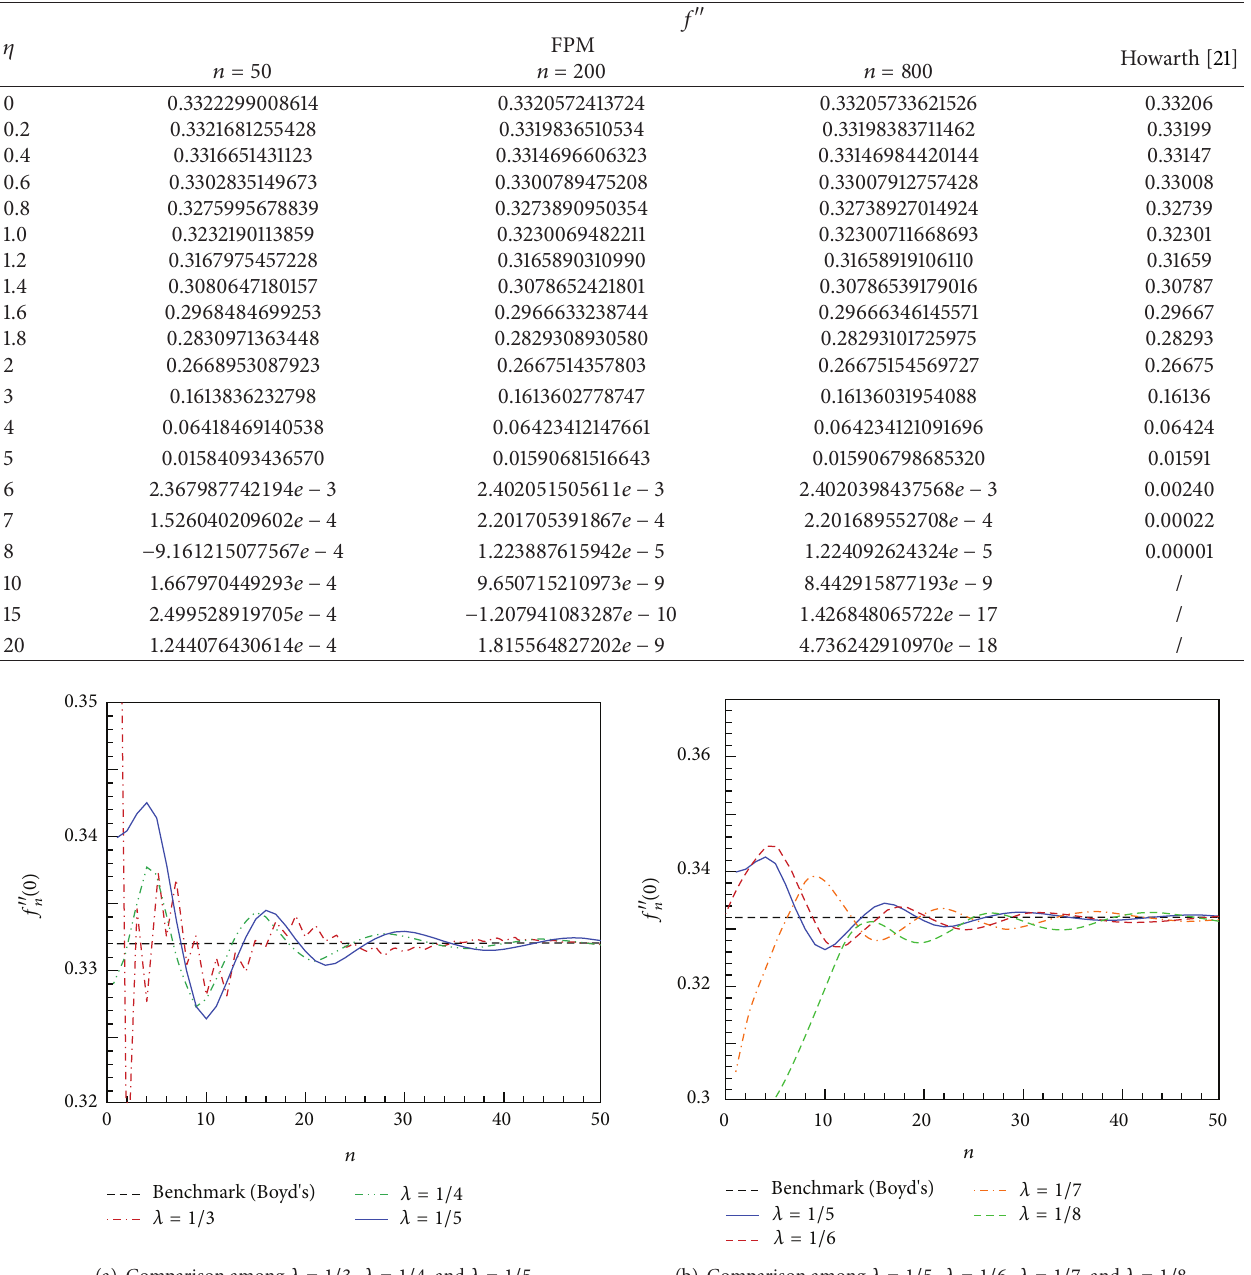
(b) Comparison among 𝜆 = 1/5 , 𝜆 = 1/6 , 𝜆 = 1/7 , and 𝜆 = 1/8 Figure 6: The influence of 𝜆 value on the convergence of 𝑓 󸀠󸀠 𝑛 (0)